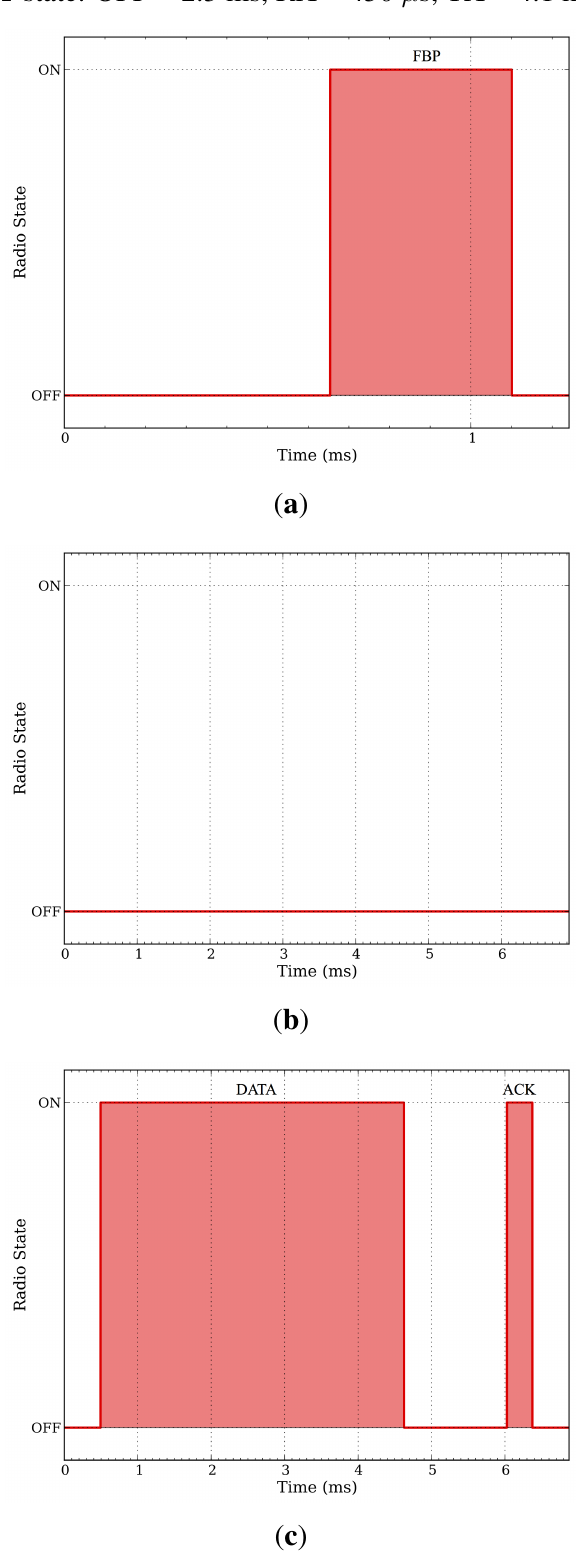
Figure 7. Frame Slotted ALOHA (FSA) states and radio activity. The total slot length is 6.85 ms, yielding an overall of 145 packets per second. In FSA the FBP_LISTEN state duration is shorter ( 1 . 25 ms) than other states. ( a ) FBP_LISTEN